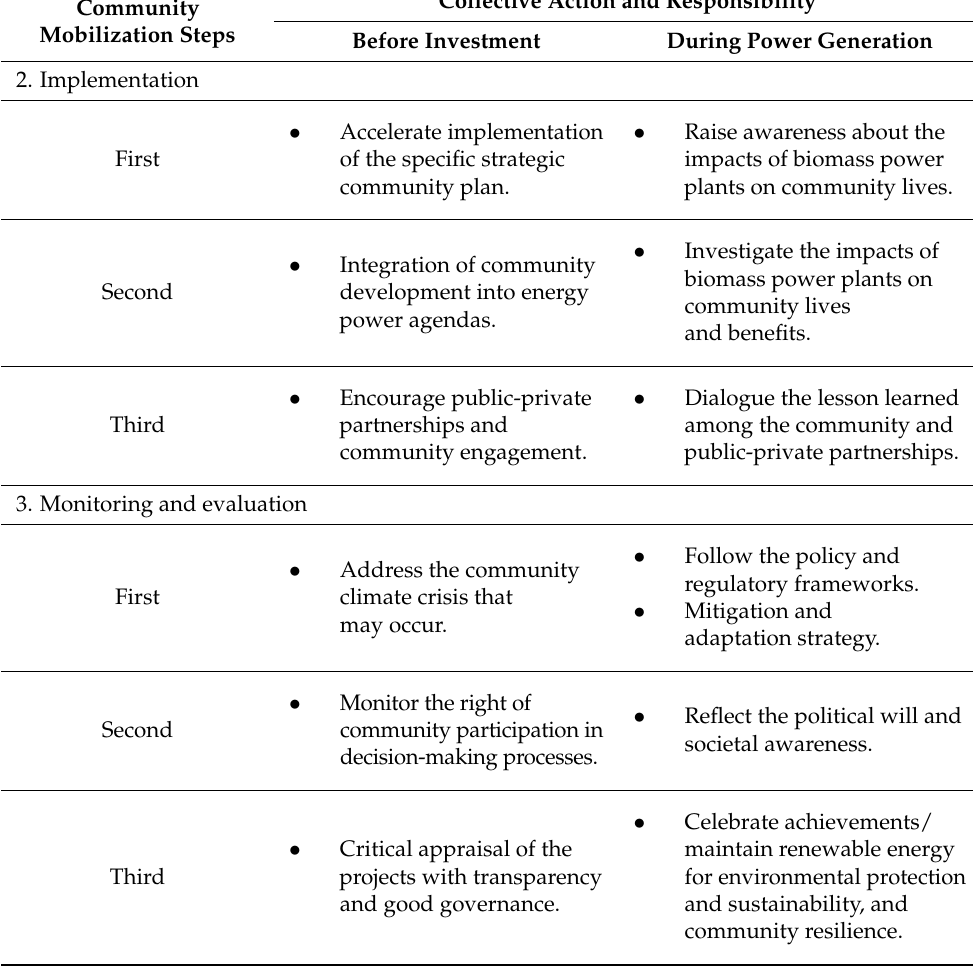
Table 5. Cont. Community Mobilization